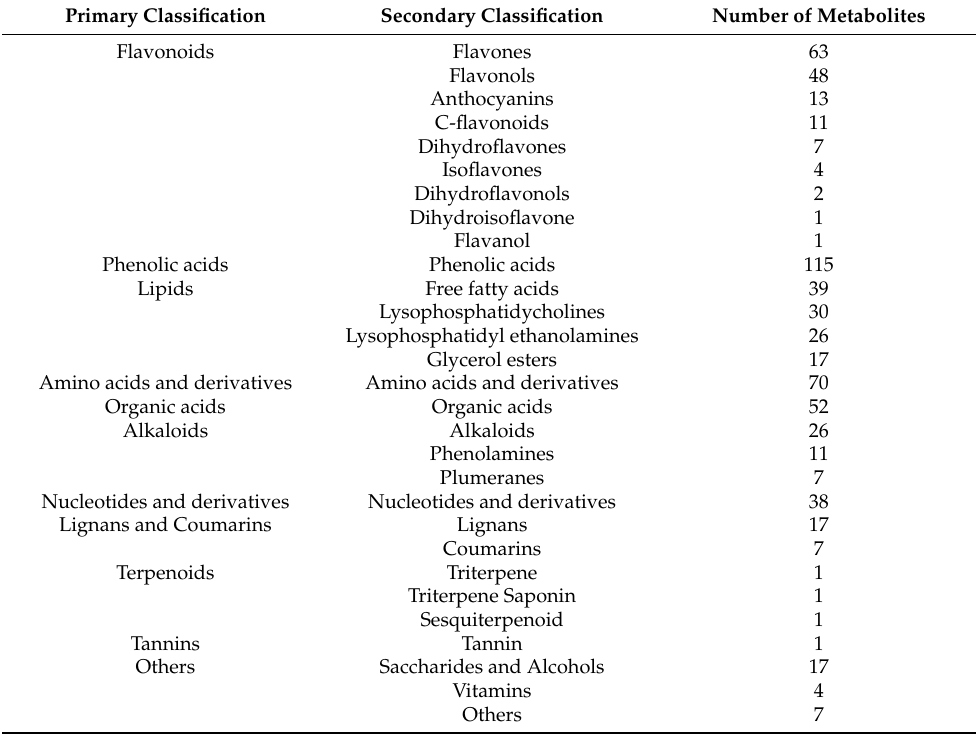
Table 1. Overview of the identified metabolites in S. collina